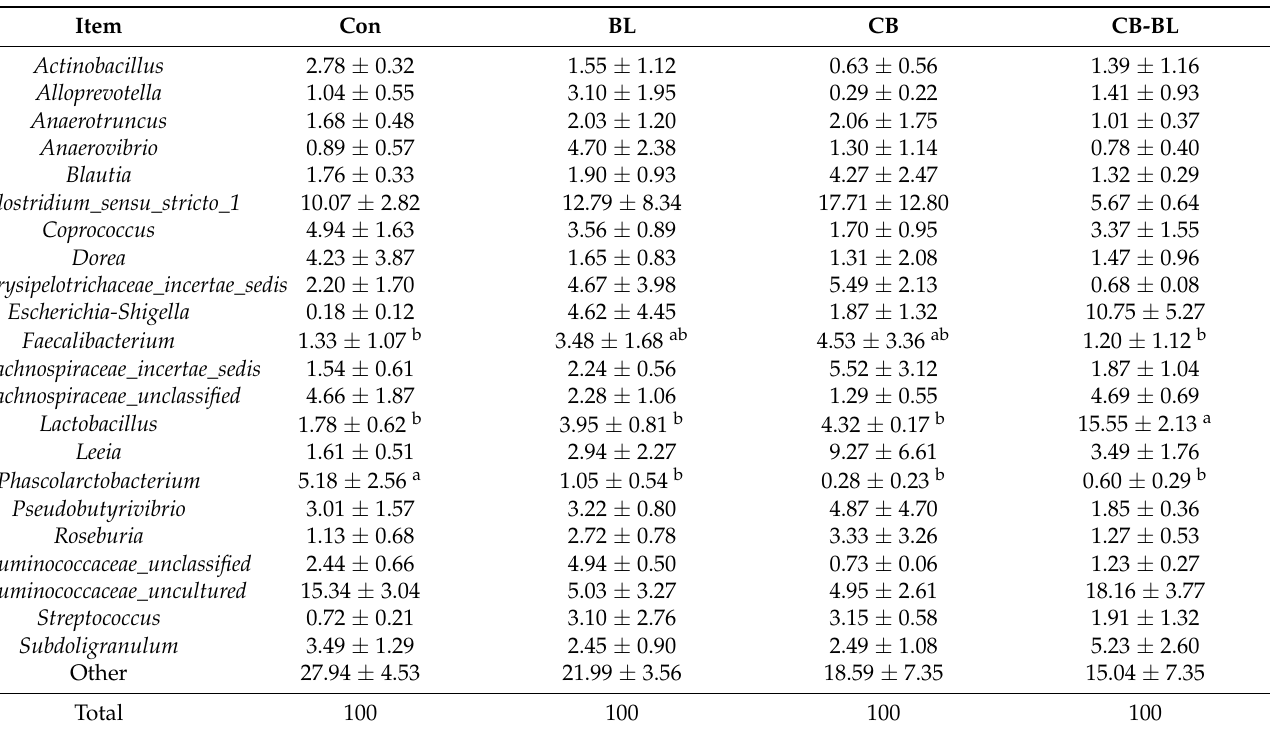
Table 4. The percentages of cecal contents dominant bacteria in Genus